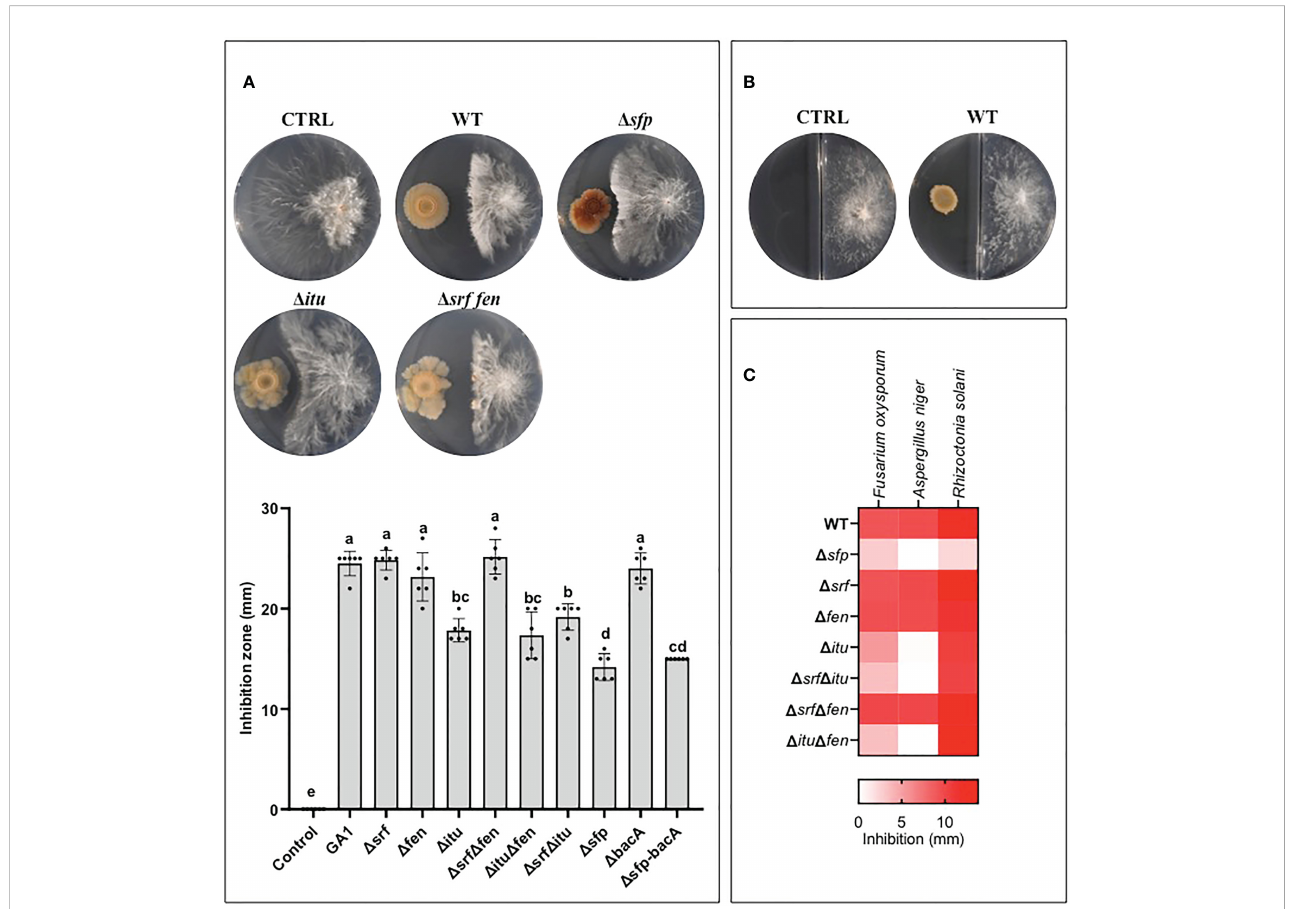
FIGURE 3 (A) Illustration of the antagonistic activity displayed by B. velezensis GA1 WT and its mutant strains impaired in production of different lipopeptides as observed on MMPRE medium against A . rolfsii . The corresponding quantitative data of inhibition by the different strains are represented in the graph below. Means ± SD from six independent repetitions of one experiment are presented. Treatments with different letters are signi fi cantly different (p<0.05). (B) Volatiles secreted by B . velezensis have no impact on the growth of A . rolfsii as visualized on bi-compartmented plates. (C) Heat map representing the level of antagonistic activity of GA1 WT and mutants against some other fungal pathogens of peanuts